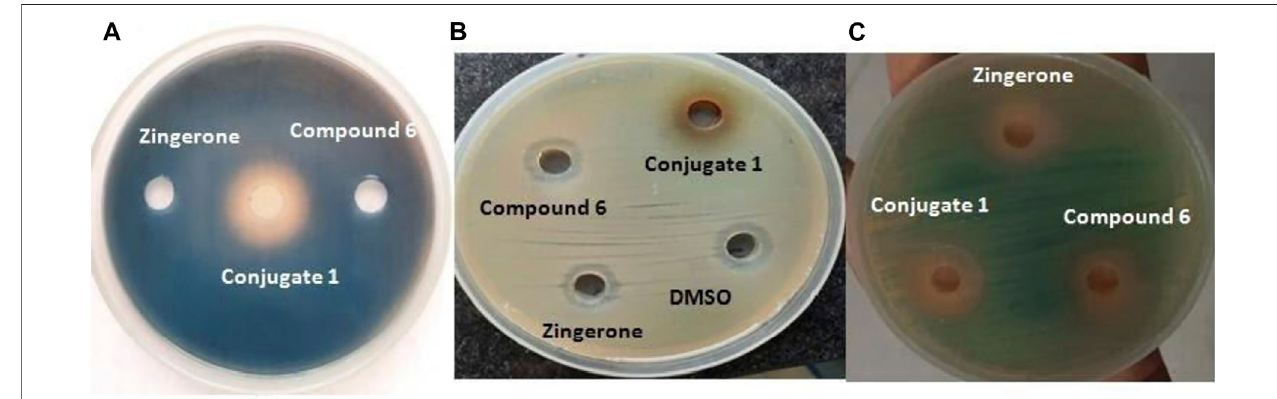
FIGURE 3 | (A) Iron chelation potential. (B) Antibacterial activity against P. aeruginosa . (C) Anti quorum activity of synthetic catechol – zingerone conjugate ( 1 ), compound 6 , and zingerone